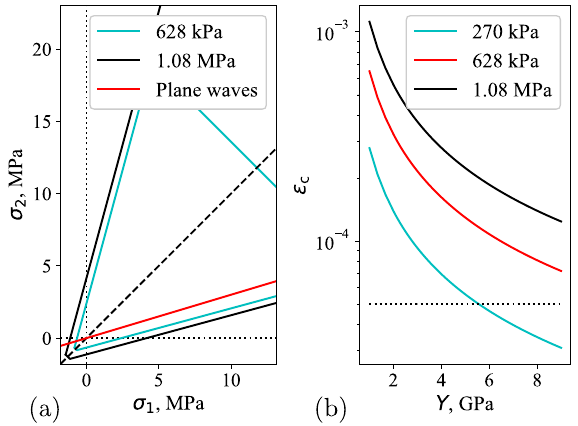
Figure 2. (a) Mohr–Coulomb fracture envelope for different val- ues of the cohesion. The red line shows the line σ 2 = νσ 1 , where ν = 0 . 3 is Poisson’s ratio – this gives the relationship for plane waves in a thin elastic plate. When the ice has thickness 1m, Young’s modulus 5.49GPa, and the wave period is 12s, the red line meets the black one when the wave height is about 60cm. The dashed line shows the symmetry of the envelopes in the line σ 2 = σ 1 . (b) Breaking strain for different values of the cohesion and Young’s modulus ( Y ). The dotted line corresponds to ε c = 5 × 10 − 5